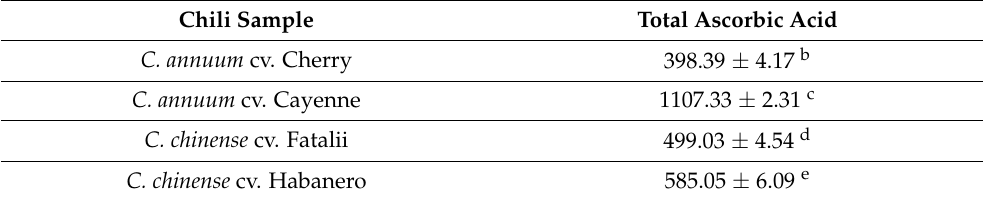
Table 4. Variation of ascorbic acid content in the examined freeze-dried fermented chili powder samples.